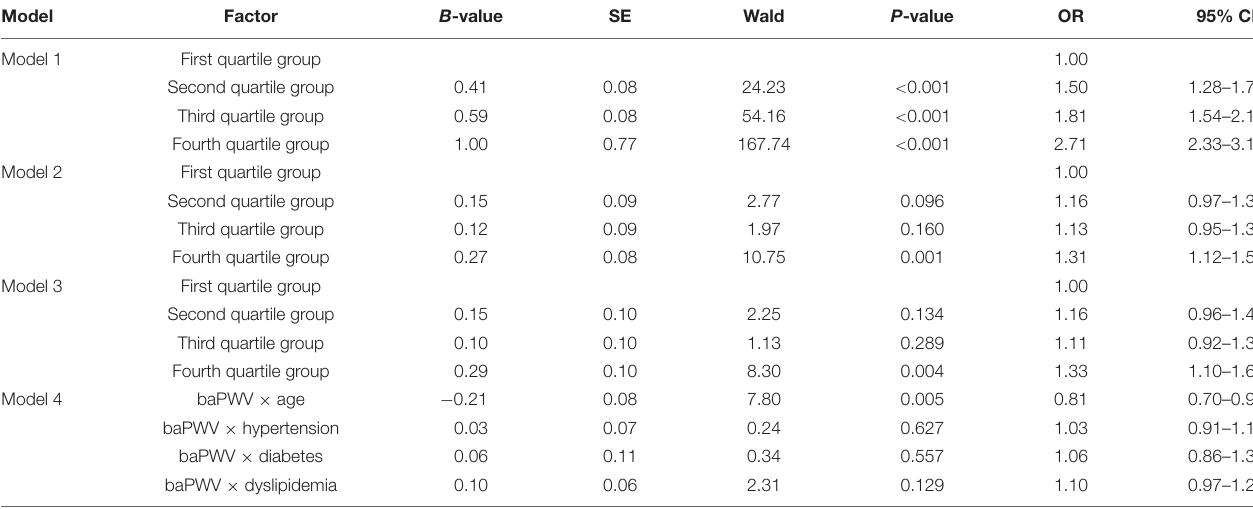
TABLE 2 | Multivariate logistic regression analysis of baPWV quartile groups for HI. Model